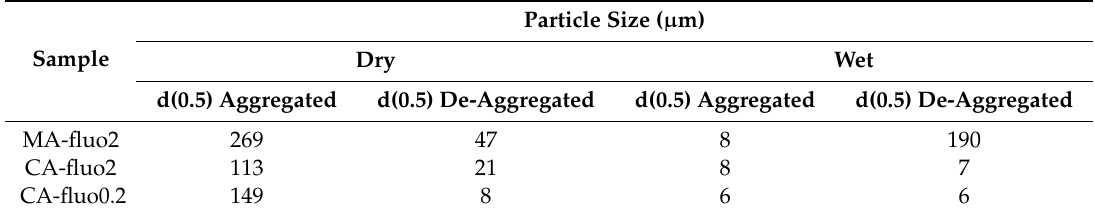
Table 6. d(0.5) 1 values ( µ m) of the particle size distribution of the aggregated (untreated) and de-aggregated samples (after 15 min ultrasound